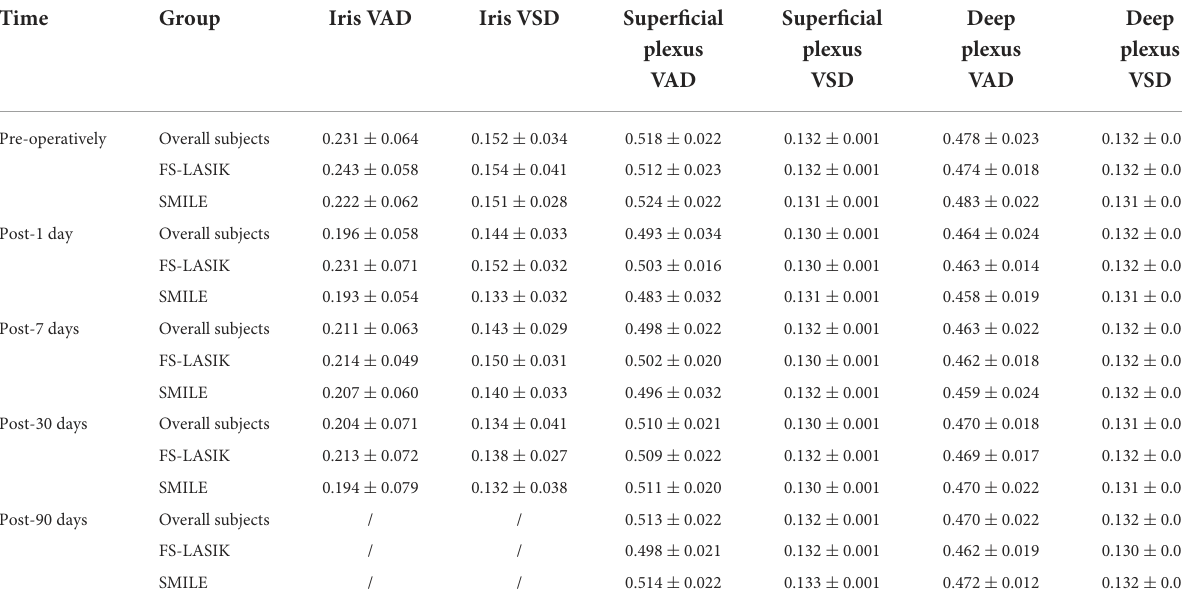
TABLE 3 Iris and retinal VAD and VSD with